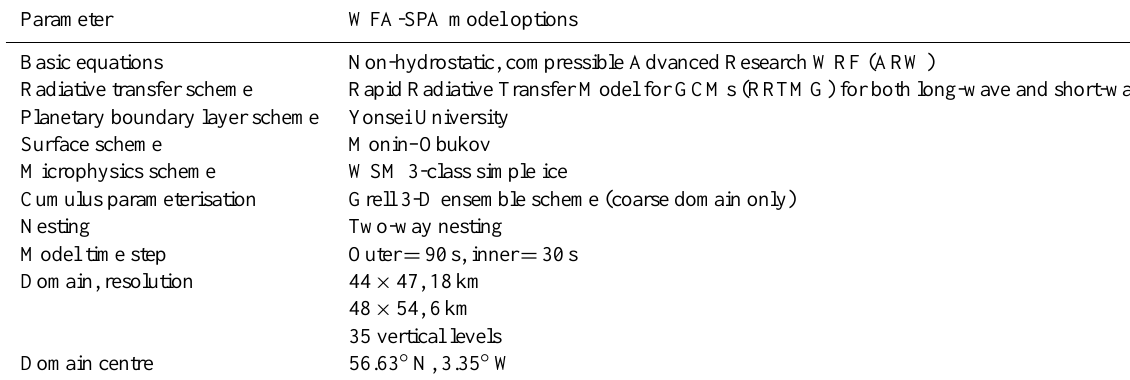
Table 2. Parameter and model options used in WRF-SPA.